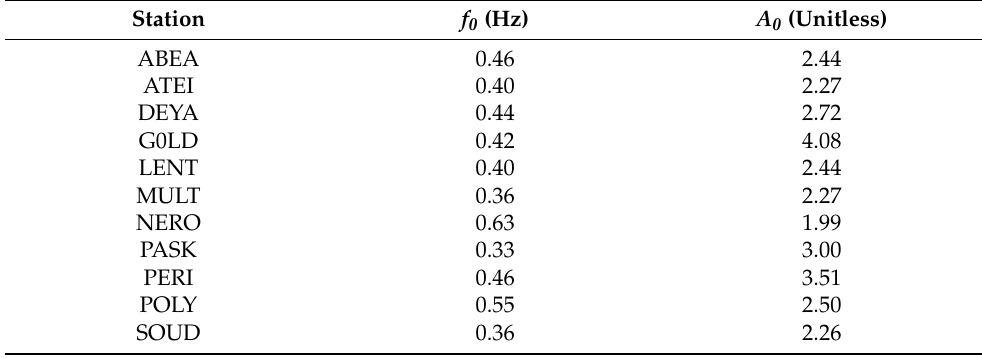
Table 3. The ground motion predominant frequency f 0 and amplitude A 0 at SGMN’s